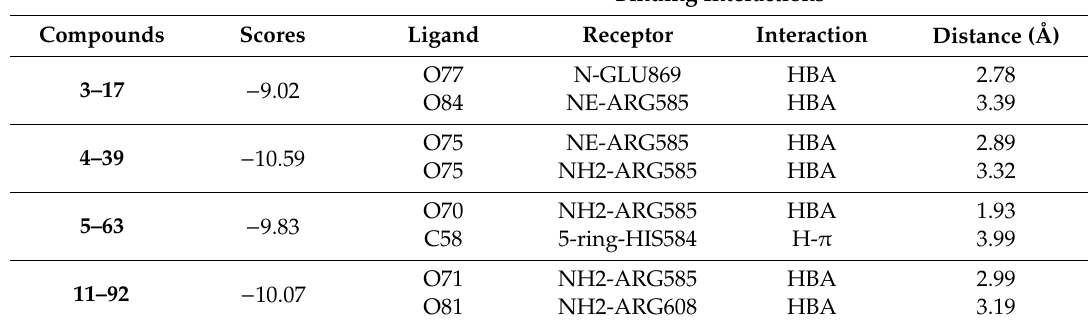
Figure 7. Structural topology of S. cerevisiae α -glucosidase is shown. The generated cavities are displayed in boxes. The predicted allosteric sites are shown in sphere model, each site is labeled. The active site residues (shown in yellow sticks) are presented in complex with the substrate molecule (isomaltose, shown in purple sticks).